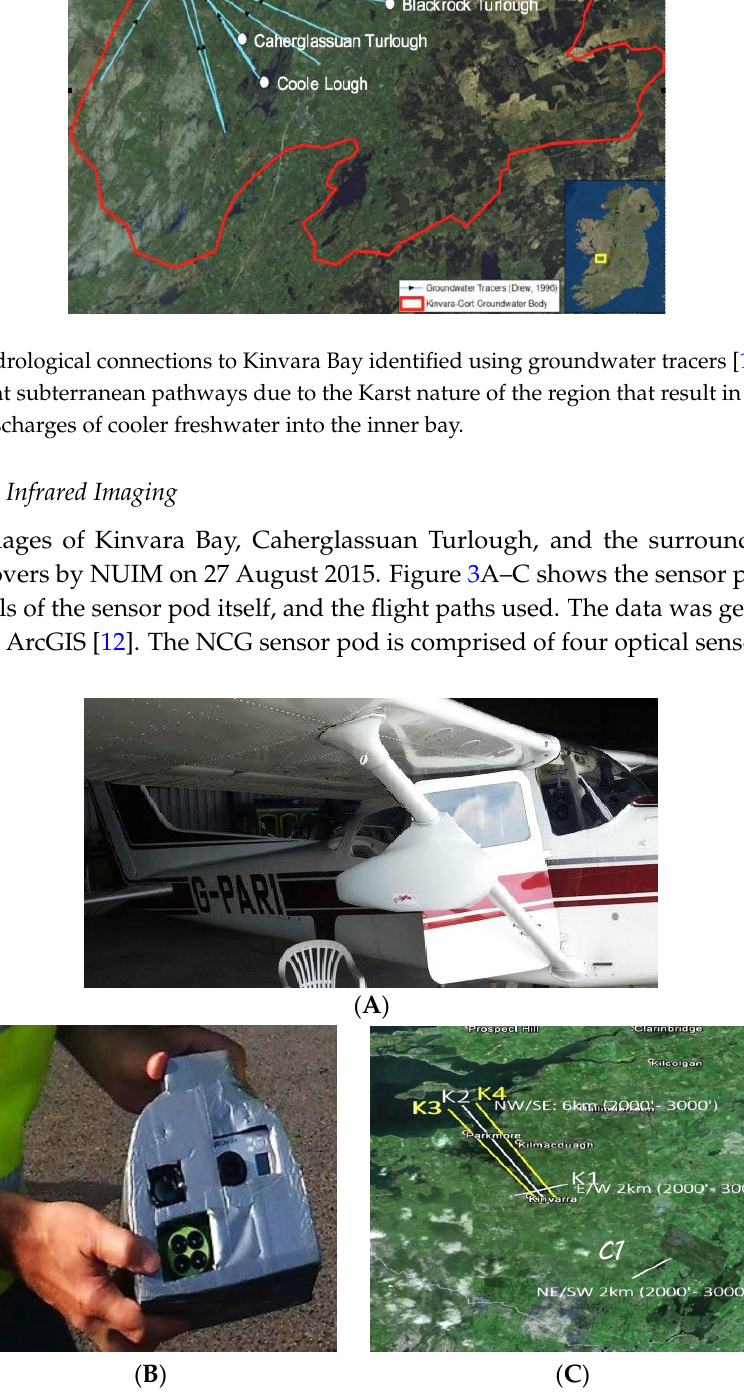
Figure 3. ( A ) Sensor pod mounted on the wing strut of a Cessna 172 light aircraft; ( B ) The NCG sensor pod used to acquire data; ( C ) Flight paths for aerial flyovers of Kinvara Bay and catchment area. K1 covers the inner bay while K2, K3 and K4 map the length of the bay from Kinvara to the mouth of the bay.